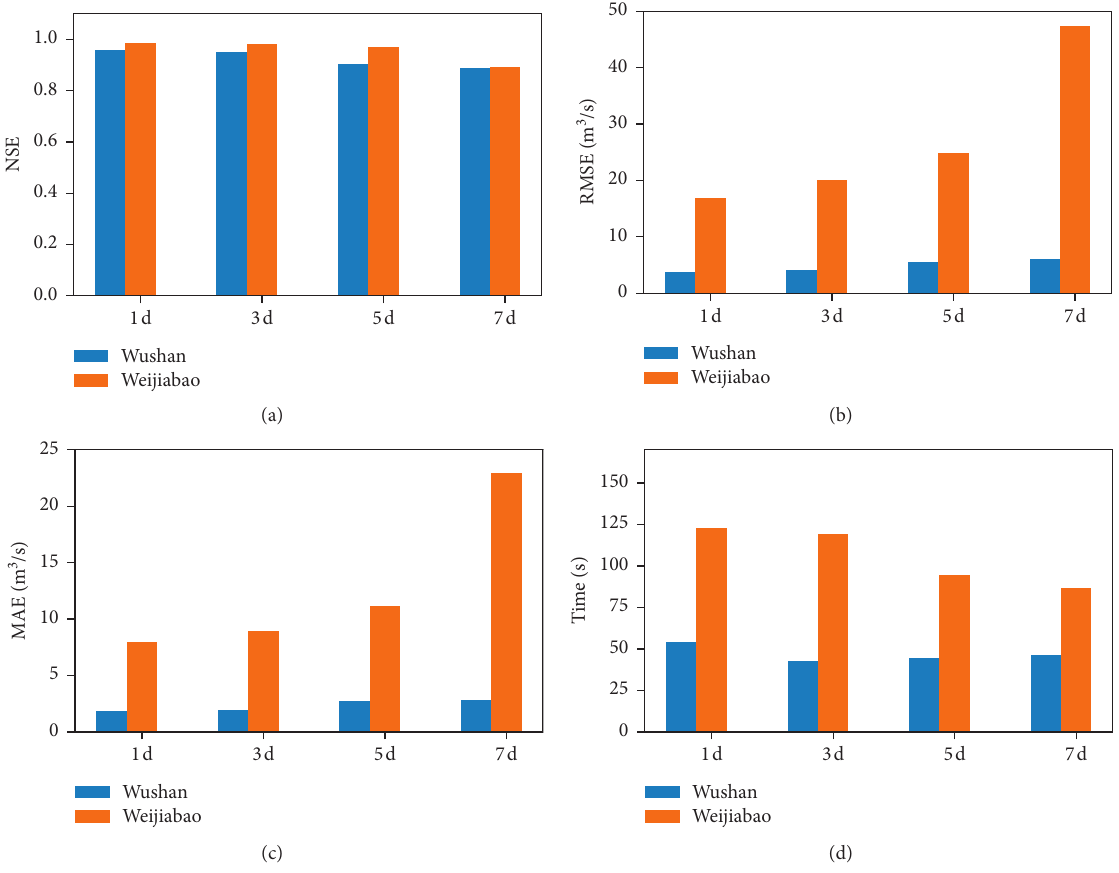
Figure 12: Streamflow forecast scores (computed over the verification period) for the VMD-BPNN model between the observations and predicted streamflows for the 1-d, 3-d, 5-d, and 7-d ahead forecasts, which were evaluated using the (a) Nash–Sutcliffe efficiency coefficient (NSE), (b) root mean squared error (RMSE), (c) mean absolute error (MAE), and (d) time